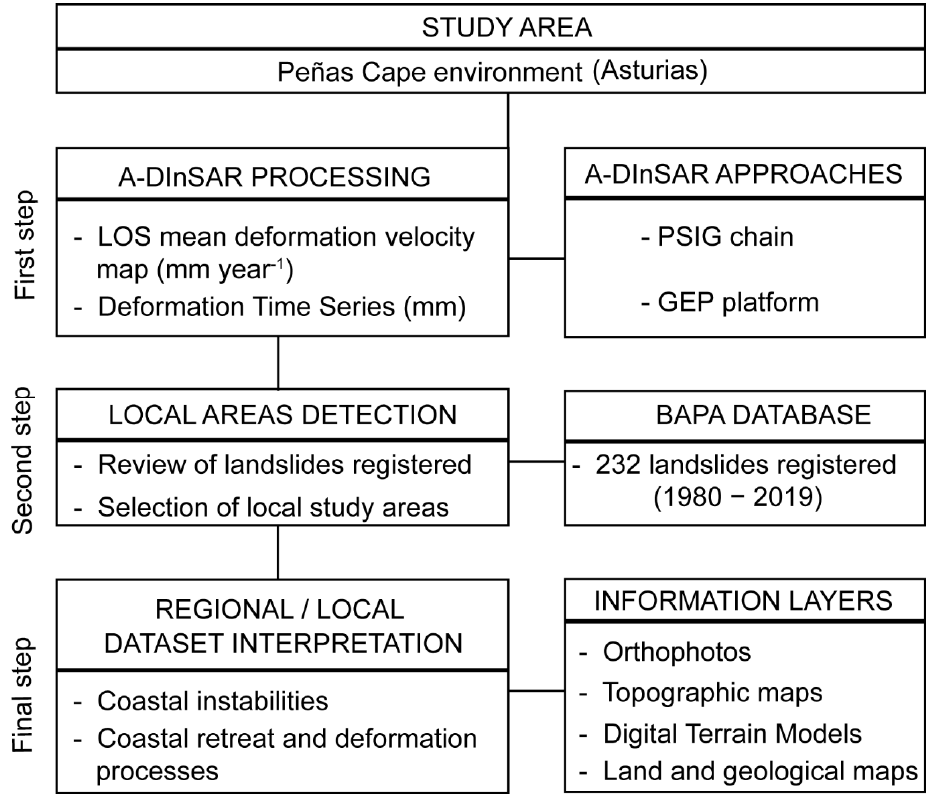
Figure 2. Flow diagram of the procedure and tools used in this